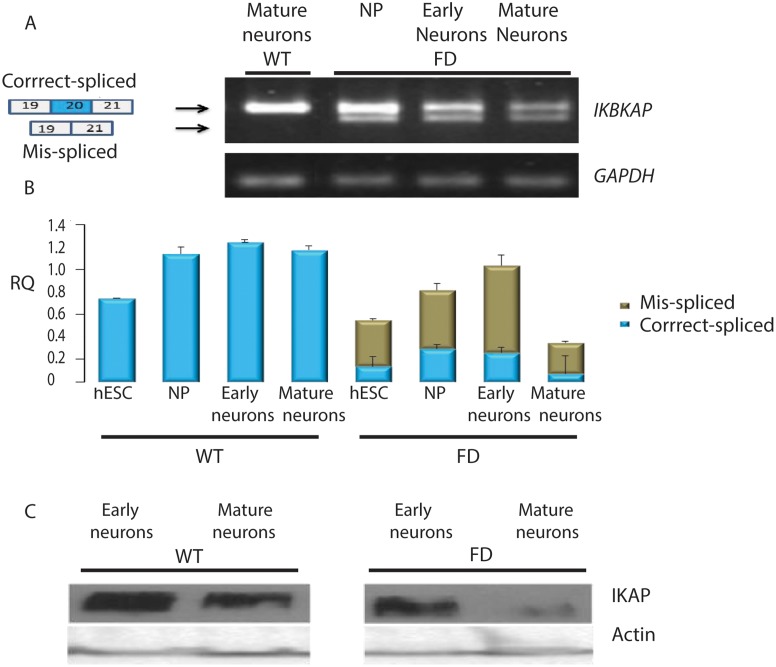
IKAP expression in WT and FD early and mature neurons.(A) RT-PCR analysis of the expression of IKBKAP showing WT (upper lane) and FD (mis-spliced, lower lane) mRNA isoforms at the stage of early neuronal precursors, early and mature neurons. (B) qRT-PCR analysis of the levels of IKBKAP WT (blue) and FD (green) mRNA isoforms. (C) Western blot analysis of IKAP protein levels in WT and FD early and mature neurons. Actin served as loading control.